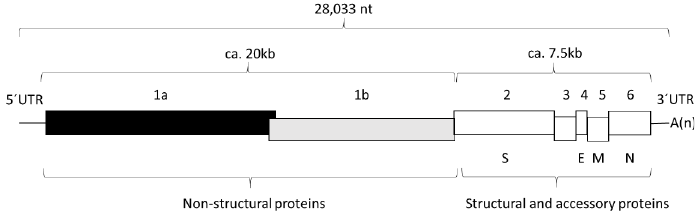
Fig 1. Representation of the genome organisation of PEDV. The open reading frames (ORFs) encoding the non- structural, structural and accessory proteins of PEDV are indicated. The genome contains untranslated regions (UTRs) at both the 5´- and 3´-termini. A poly(A) tail is present at the